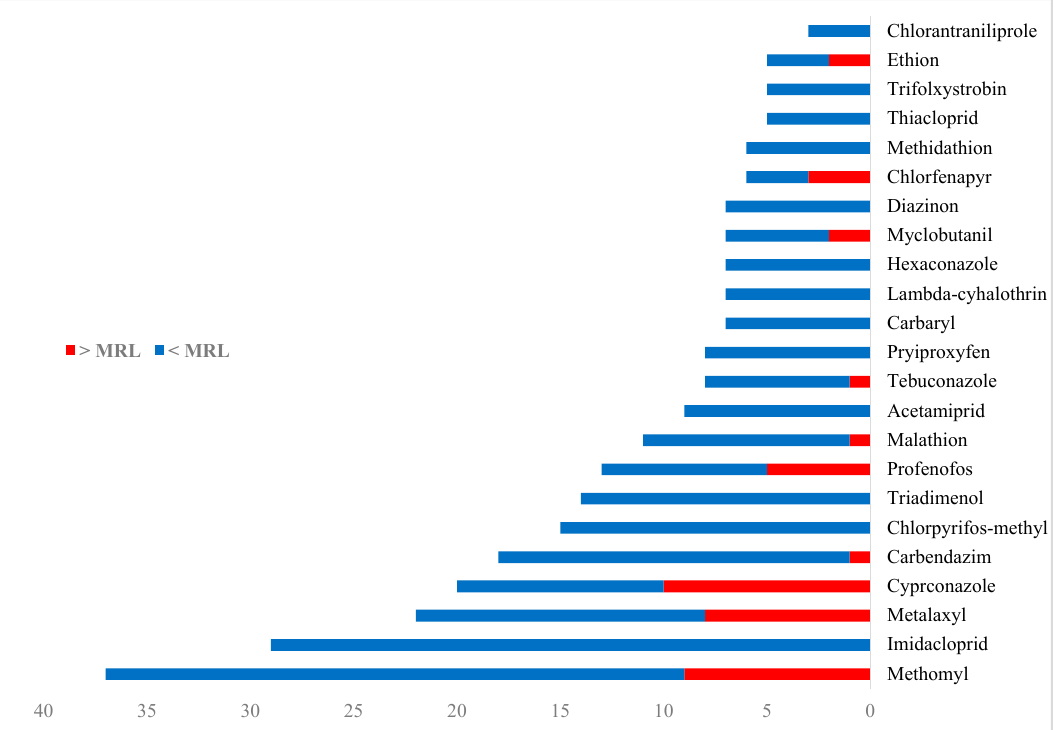
Figure 2. The co-occurrence of pesticide residues in the tested samples.